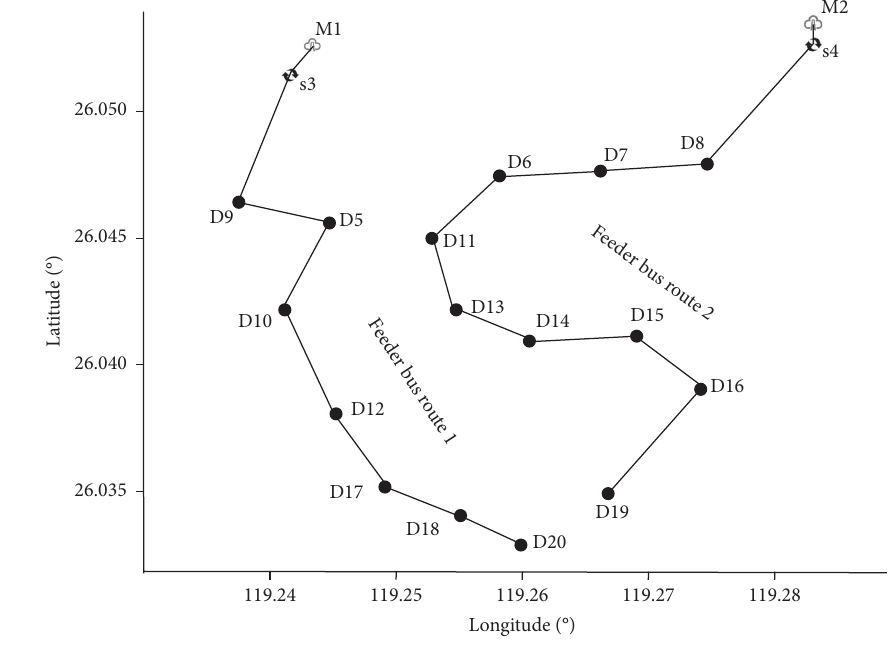
Figure 5: Optimal feeder bus routes. Table 6: Optimal connection to the feeder bus.